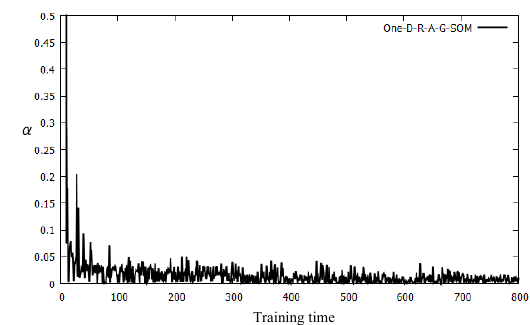
Fig.10. Parameter value in Eq. (6) changed during training